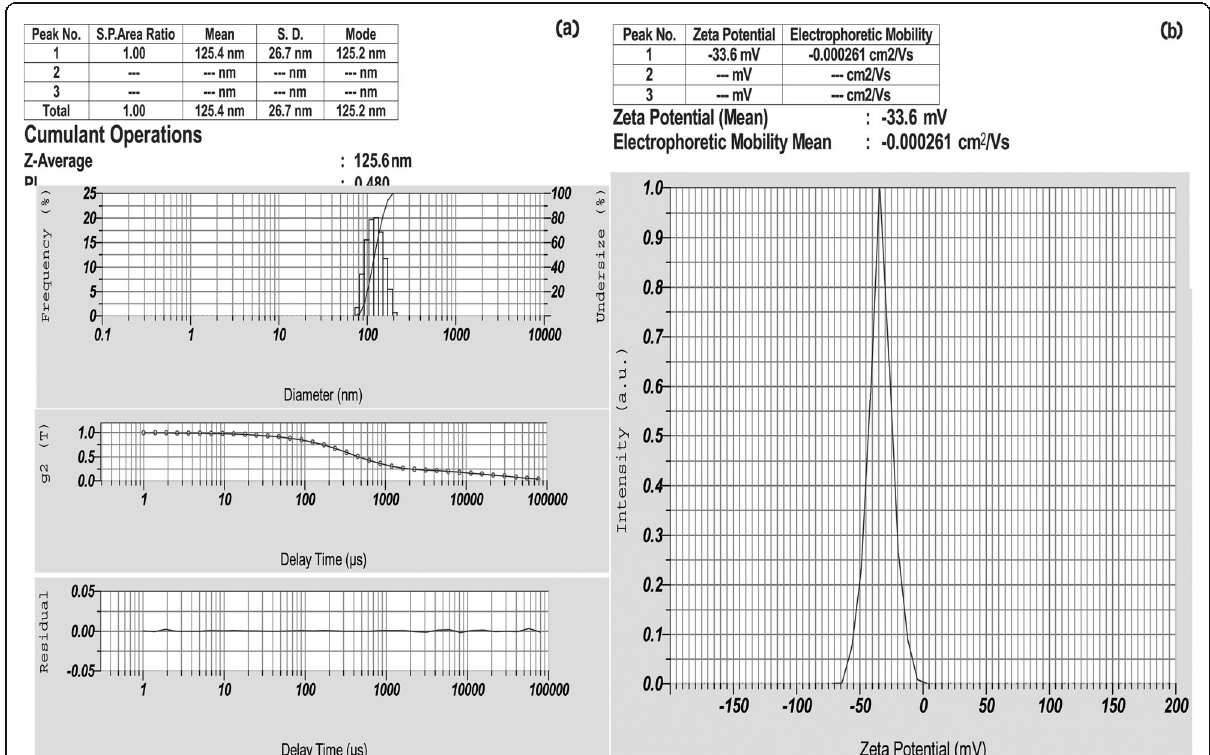
Fig. 3 a Particle size; polydispersity index of F7 nanostructured lipid carrier formulation. b Zeta potential of F7 nanostructured lipid carrier